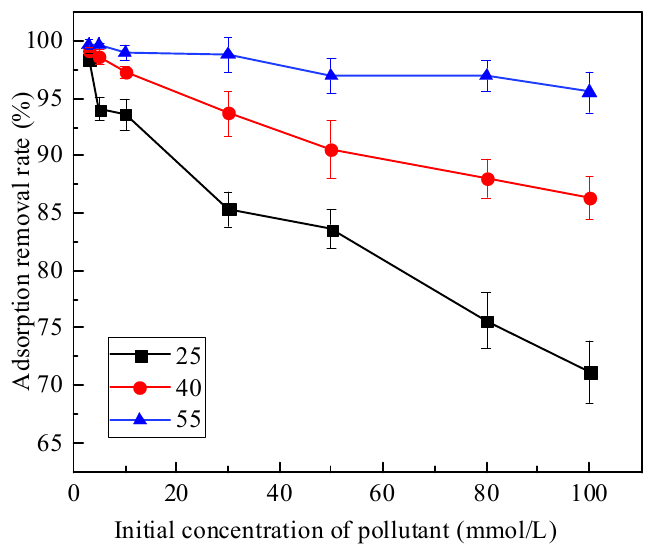
Figure 2. Relationship between initial concentration and adsorption removal rate.